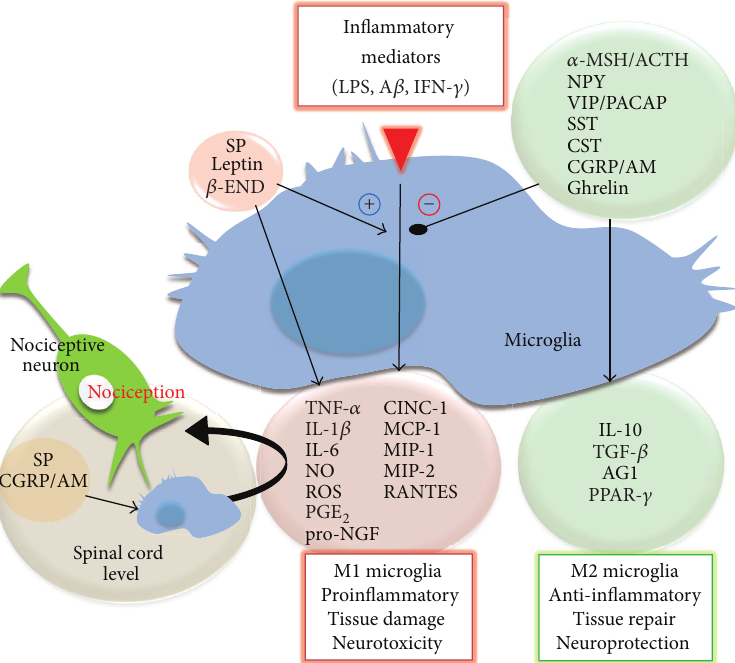
Figure 1: Neuropeptide modulation of microglial activation. In the presence of noxious stimuli such as LPS, A 𝛽 , and IFN- 𝛾 or in the context of neuroinflammation or tissue damage, microglial cells produce a plethora of inflammatory mediators that promote and perpetuate the inflammatory response, potentially leading to neurodegeneration. Neuropeptides, acting through specific receptors present in microglial cells, are able to modulate microglial response and inhibit the release of inflammatory mediators while favoring development of an alternative activation program. On the other hand, neuropeptides such as SP, 𝛽 -END, and leptin exert proinflammatory actions on microglial cells and may even potentiate the response to noxious stimuli. In experimental models of pain, certain neuropeptides such as SP, CGRP, and AM have been suggested to increase pain hypersensitivity partly by promoting proinflammatory activation of spinal cord